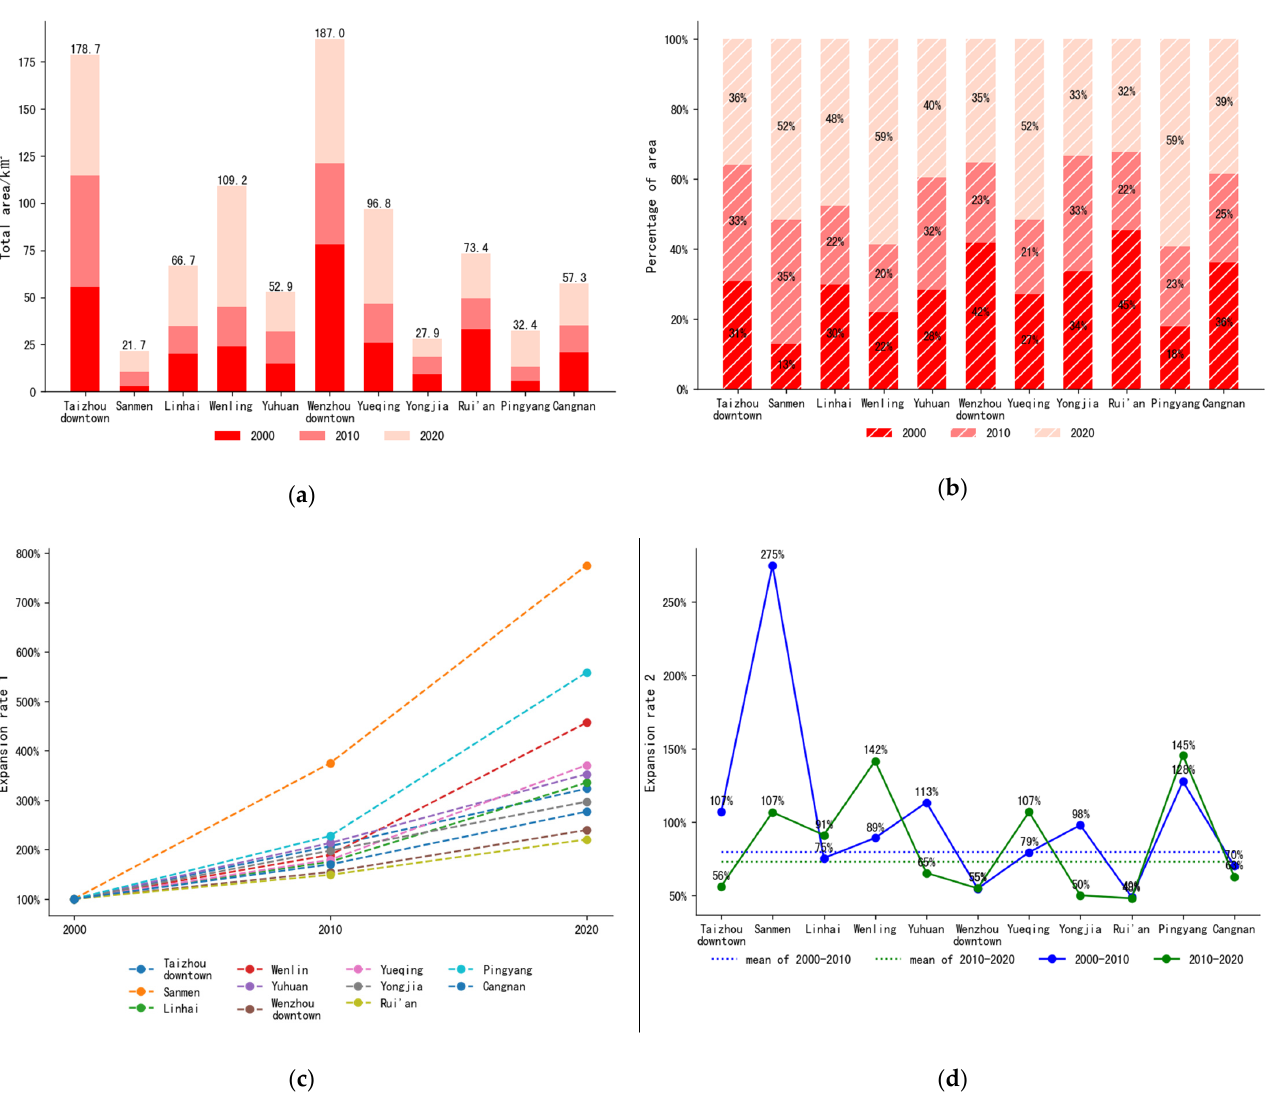
Figure 9. Visualization of Table 3: ( a ) Total area of 2000 area, 2010 new area and 2020 new area; ( b ) Area percentage of 2000’s area, new areas for 2010’s and 2020’s; ( c ) Expansion rate based on 2000’s area; ( d ) Expansion rate of 2000–2010 and 2010–2020.